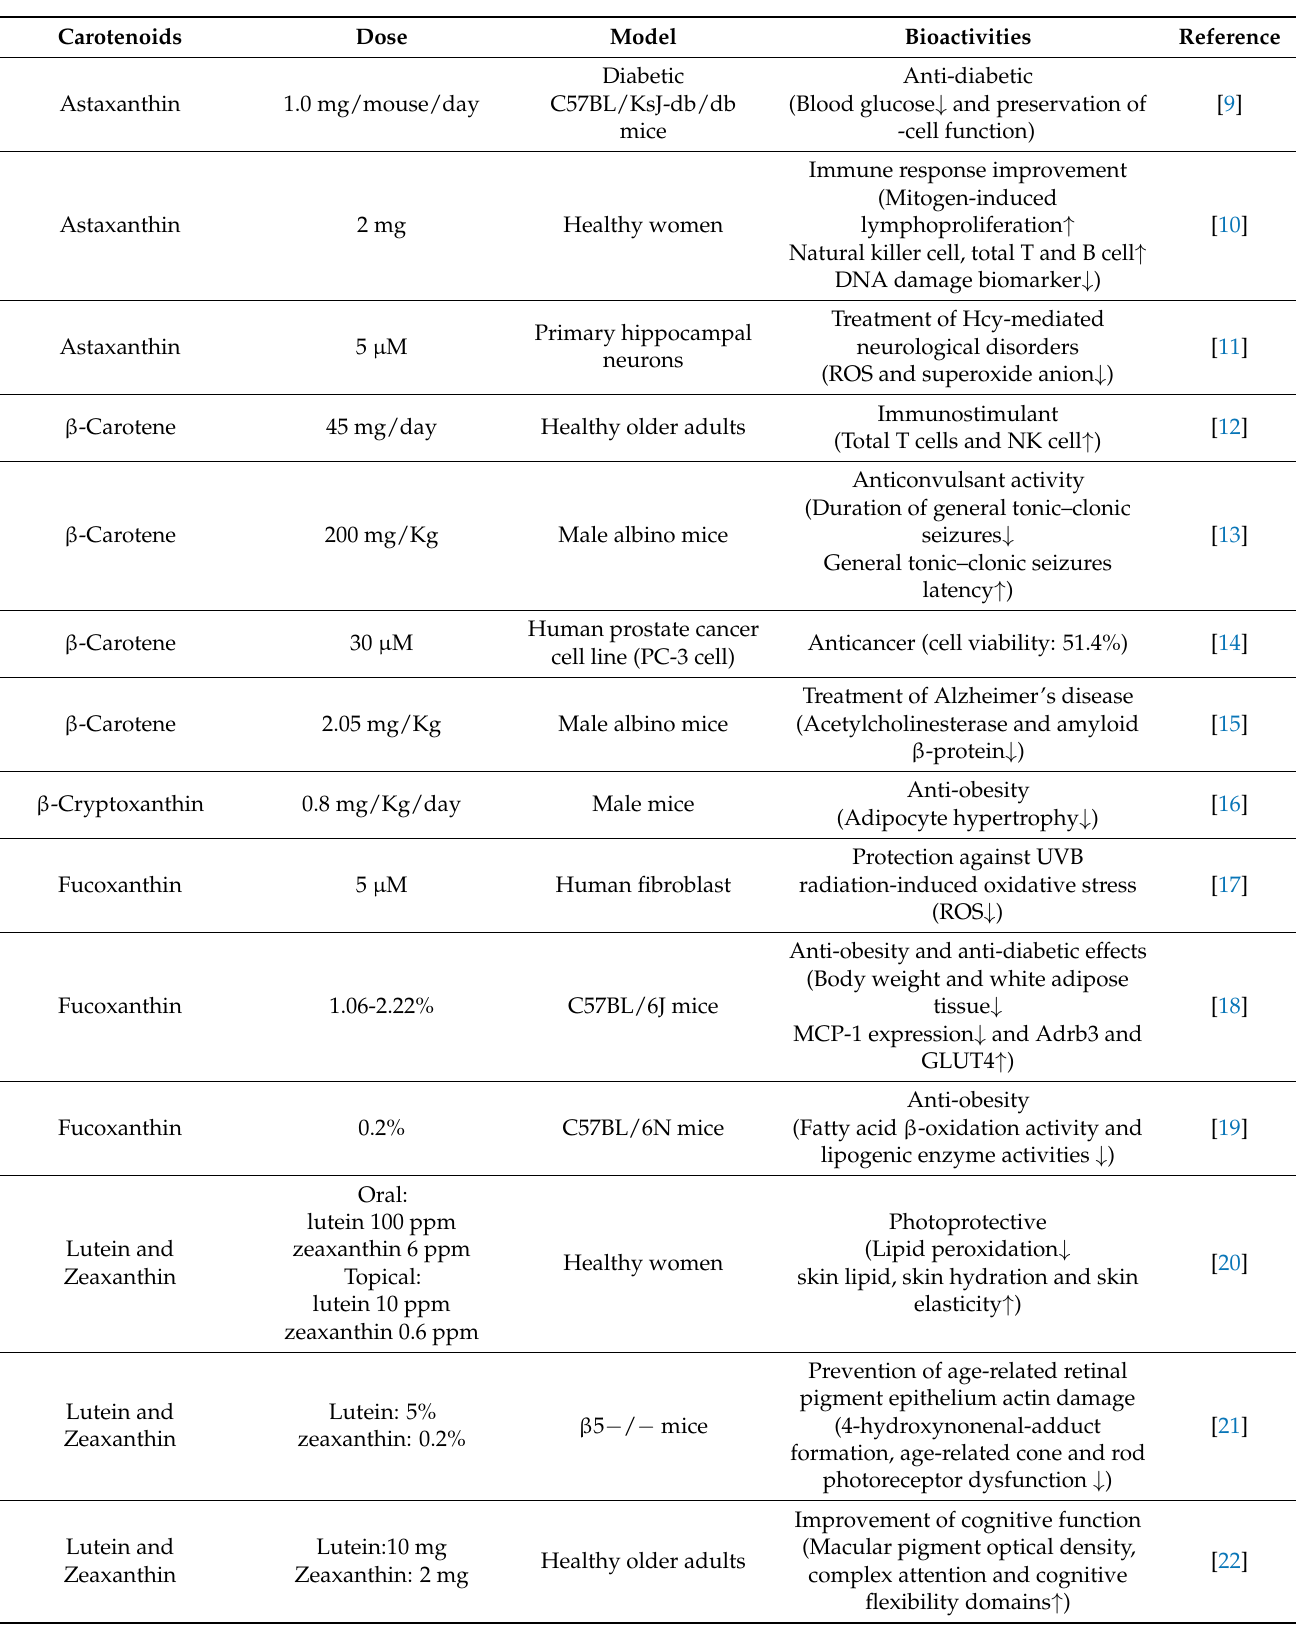
Table 1. The bioactivities of carotenoids that have been reported in previous